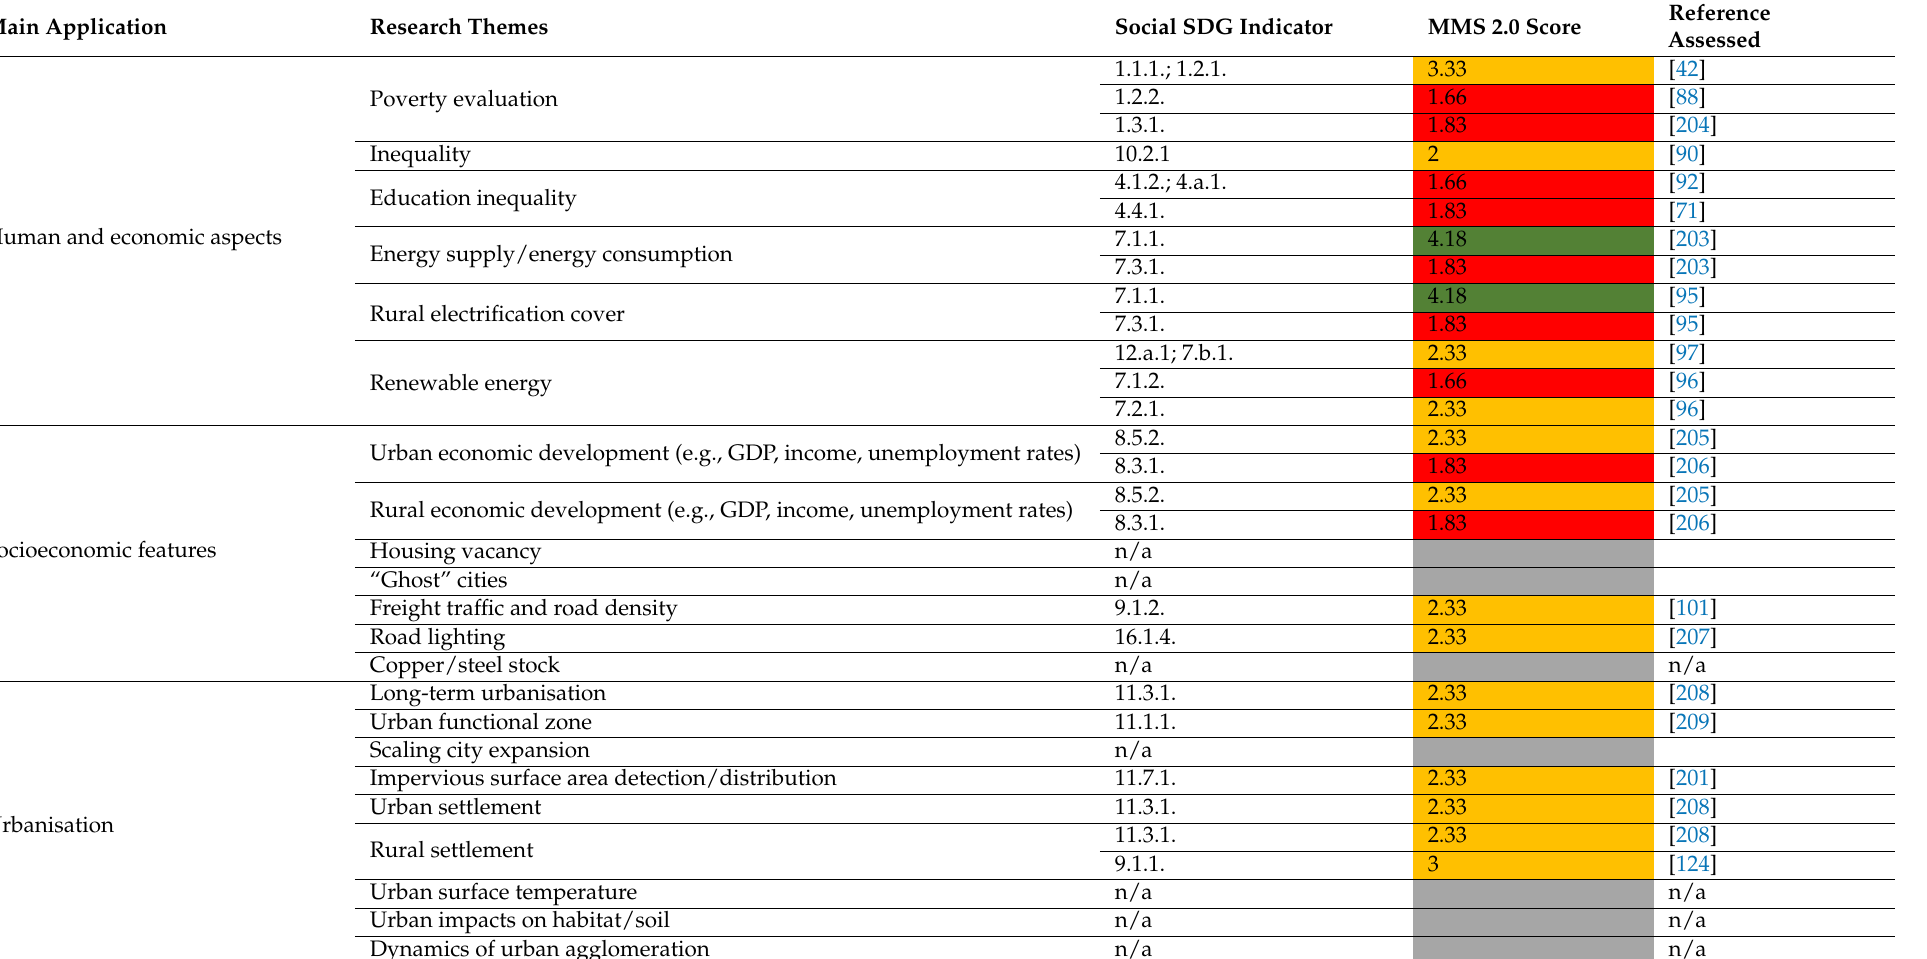
Table 4. Analysis of SDG social indicators against Maturity Matrix Score (MMS) and categorisation into research